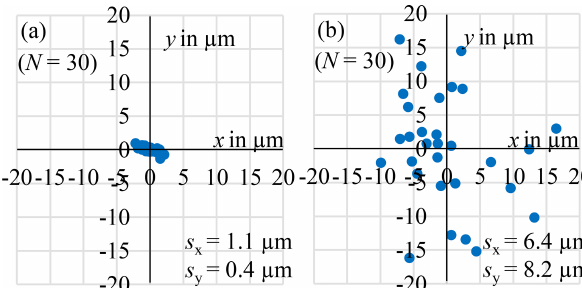
Figure 9. Temperature-dependent origin deviations of the total ref- erencing coordinate system at (a) room temperature ( ∼ 23 ◦ C) and (b) processing temperature ( ∼ 168 ◦ C).